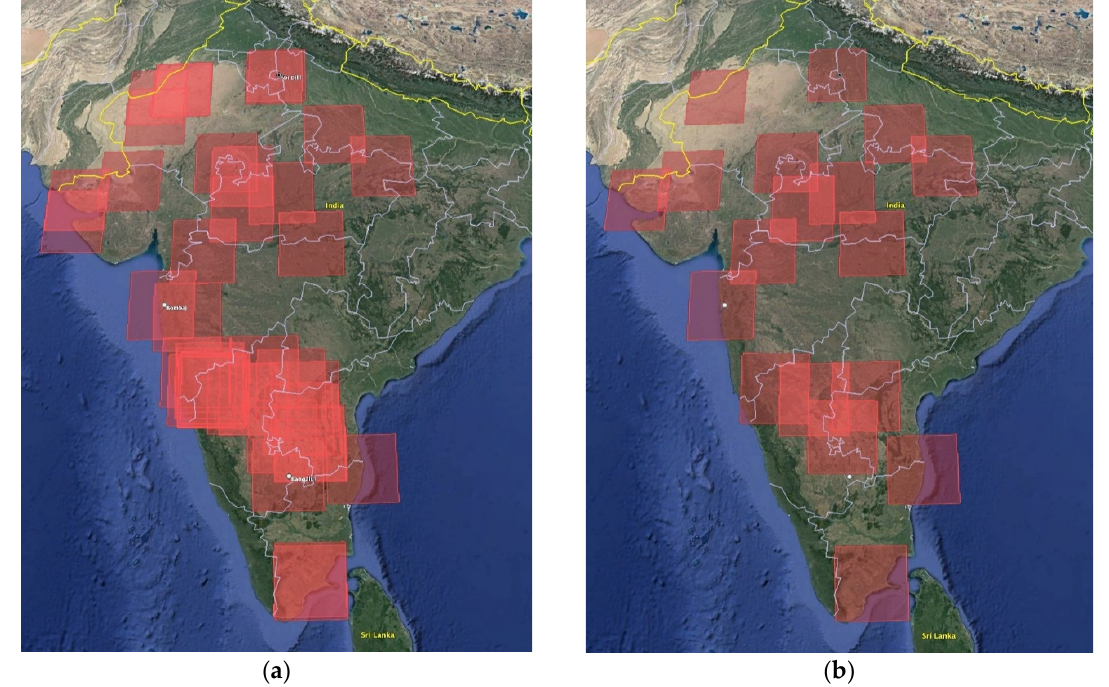
Figure 1. Visualization of the thinning of regions on the world map from Google Earth. ( a ) Initial map of regions on the left. ( b ) On the right, the resulting thinned-out map of the regions.